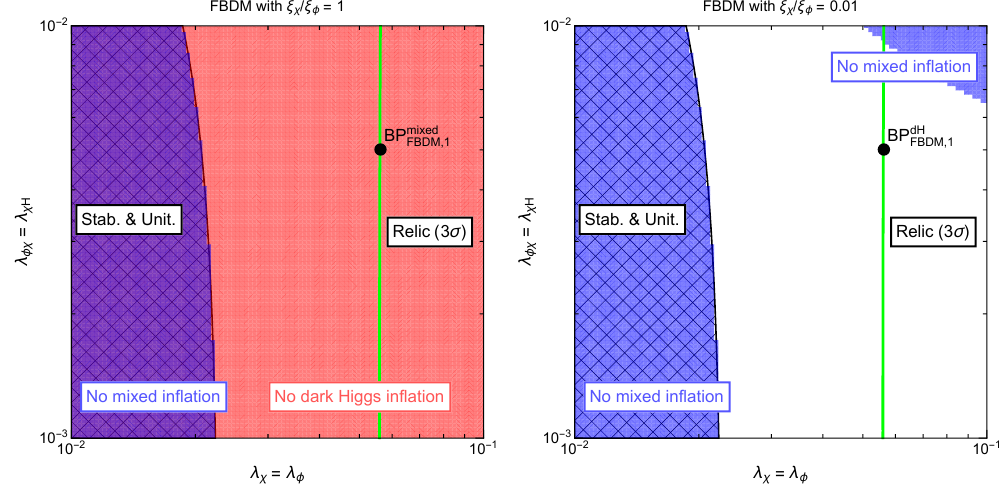
Figure 7 . Parameter space for forbidden dark matter scenario with (cid:24) (cid:31) =(cid:24) (cid:30) = 1 (left) and 0 : 01 (right) in (cid:21) (cid:31) = (cid:21) (cid:30) versus (cid:21) (cid:30)(cid:31) = (cid:21) (cid:31)H . The parameters shown here are set at low-energy scale. The rest input parameters are chosen as g X = 0 : 1, sin (cid:18) = 10 (cid:0) 5 , " = 10 (cid:0) 4 , m h 0 = 0 : 16 GeV, m (cid:31) = 0 : 1 GeV, and (cid:16) = 0 : 02. The hatched regions are disfavored due to the stability and unitarity. The dark Higgs (mixed) in(cid:13)ation is not allowed in the red-colored (blue-colored) region. The green solid lines represent the correct dark matter relic abundance within 3 (cid:27) range [2]. The black points are our benchmark points shown in table 3.